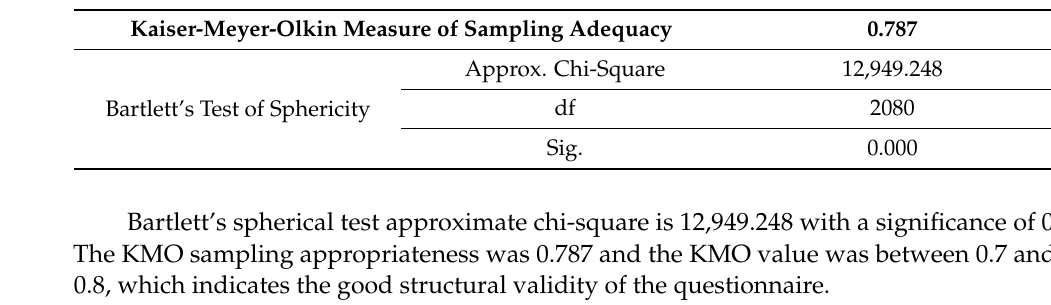
Table 3. KMO and Bartlett’s test.